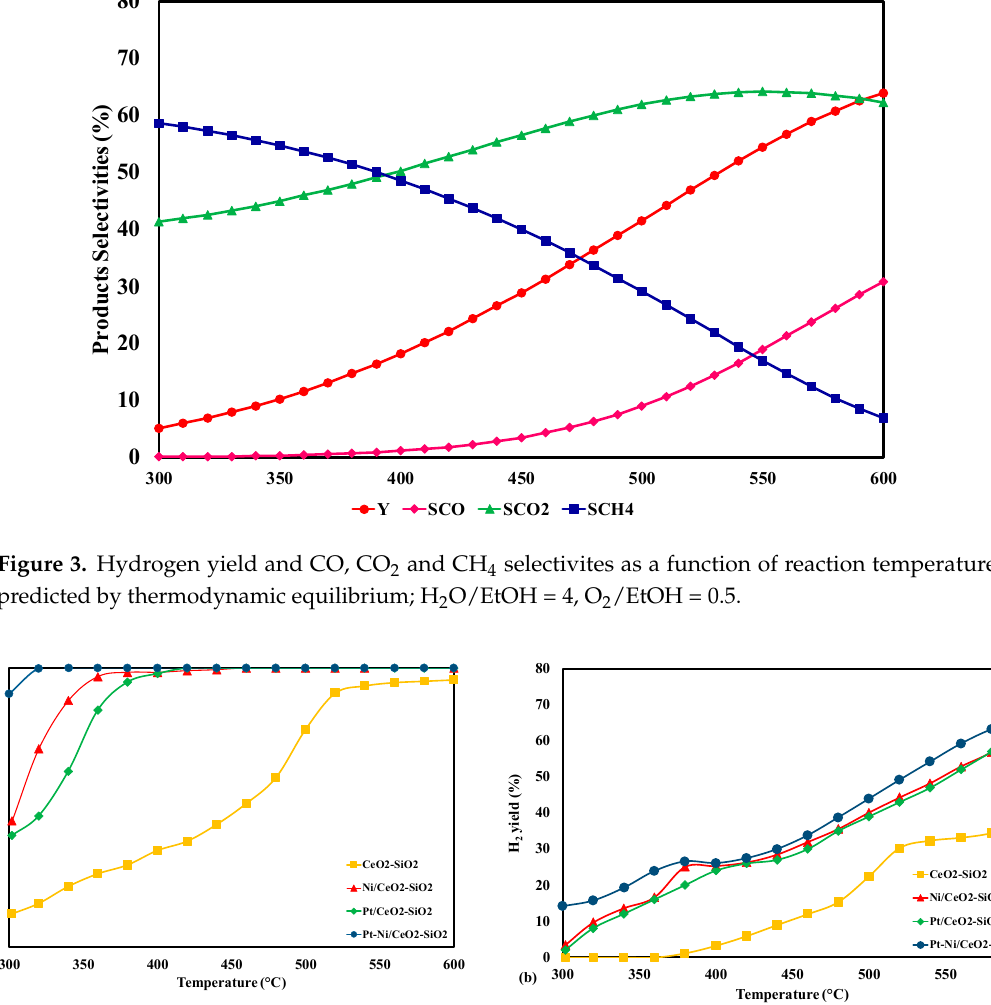
Figure 4. Ethanol conversion ( a ) and hydrogen yield ( b ) vs. temperature over the calcined support, mono ‐ and bi ‐ metallic catalysts; H 2 O/EtOH = 4, O 2 /EtOH = 0.5, WHSV = 4.1 h − 1 .